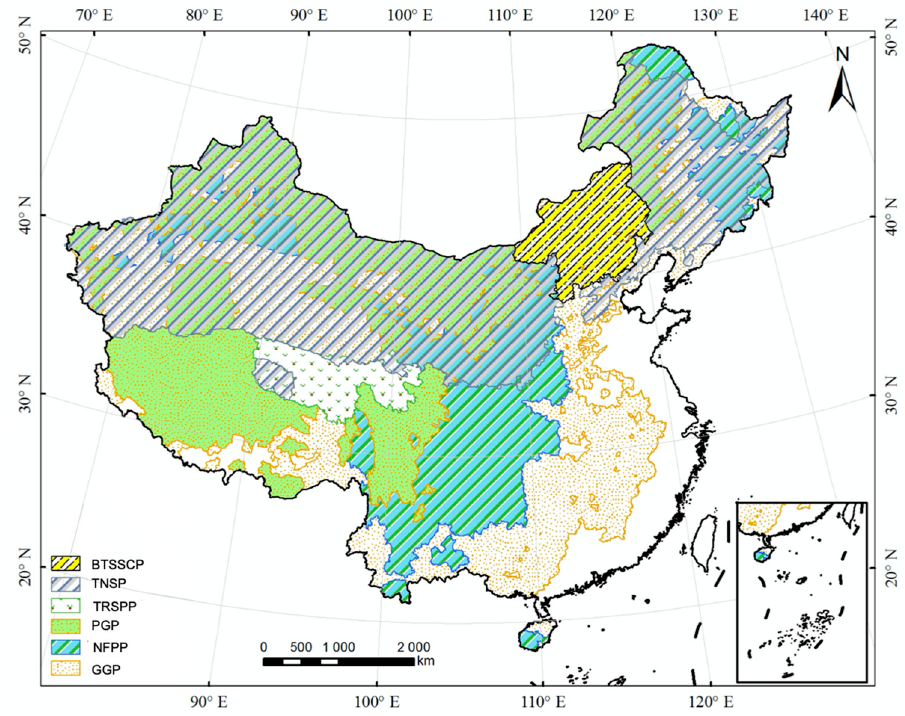
Figure 1. Scope of National Programs (2000–2010) (Adapted from IGSNRR-CAS, 2014)